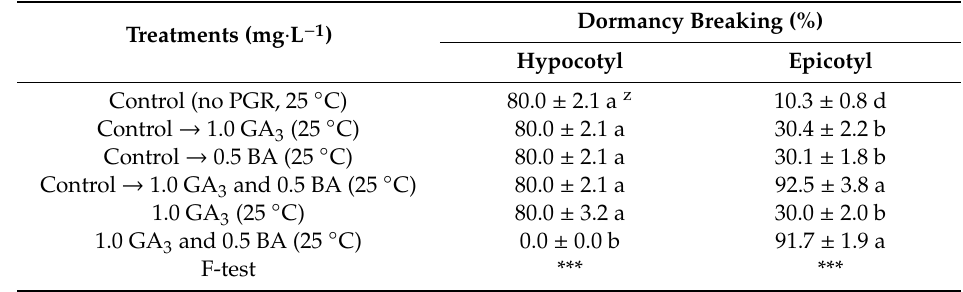
Table 3. The e ff ect of the BA and GA 3 on epicotyl dormancy breaking in a two-stage culture Table 3 . The effect of the BA and GA 3 on epicotyl dormancy breaking in a two-stage culture method.